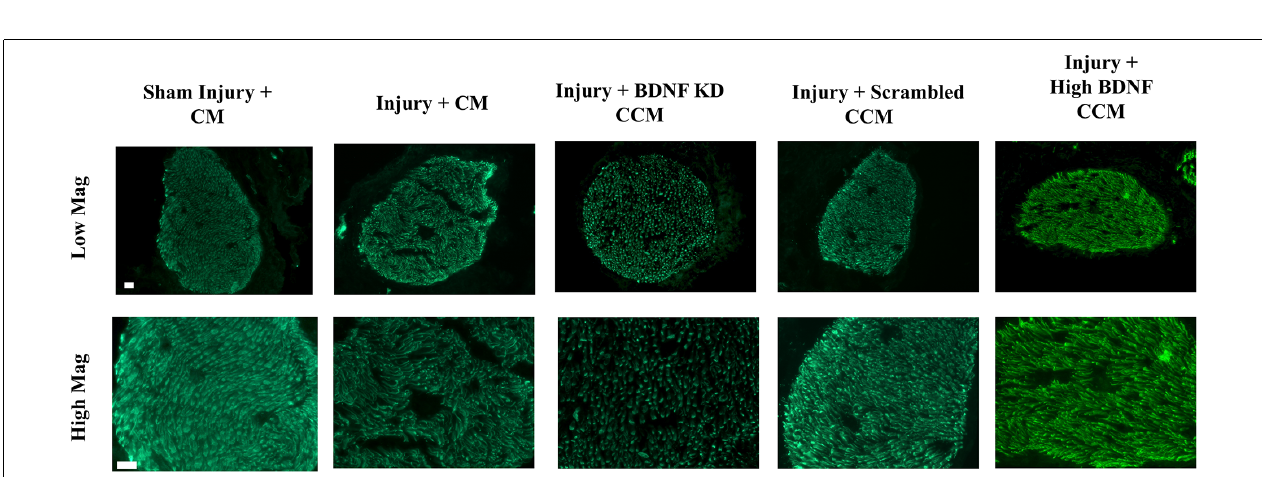
FIGURE 6 | Examples of pudendal nerve sensory branch immunostaining of axons from each group: Sham Injury + Control Media (CM), Injury (Pudendal Nerve Crush + Vaginal Distension) + CM, Injury + Brain-Derived Neurotrophic Factor Knockdown (BDNF KD) Concentrated Conditioned Media (CCM), Injury + Scrambled CCM, or Injury + High BDNF CCM. The white scale bar indicates 20 µ m in both top and bottom